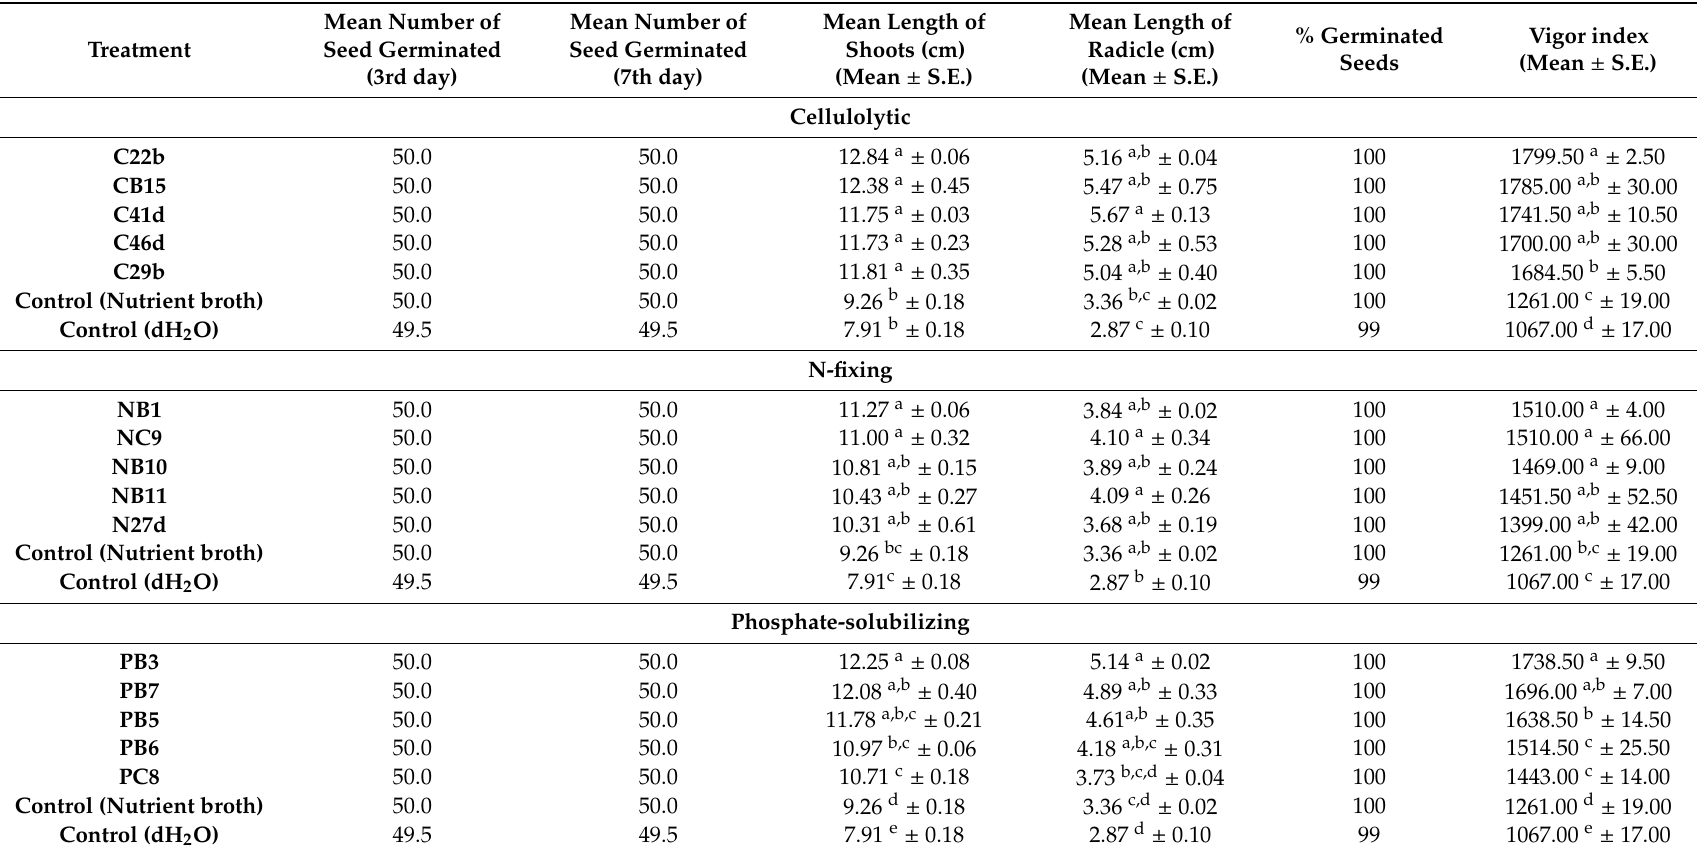
Table 5. E ff ects of selected cellulolytic, N-Fixing, phosphate-solubilizing bacterial inoculation on the early growth stage of green gram.